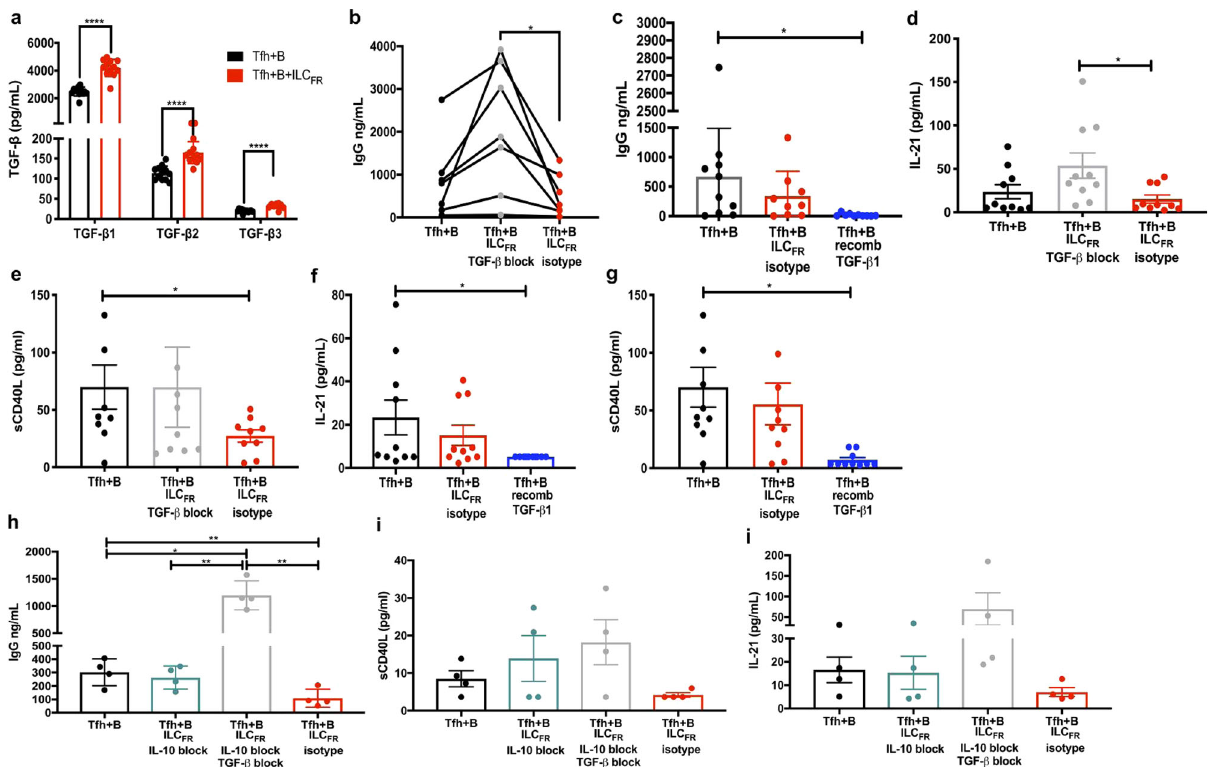
Fig. 5 ILC FR -derived TGF- β attenuates the interaction of GC-Tfh and GC-B cells and reverses with blockade. a Production of TGF- β in the supernatants of 5-day co-culture: 30,000 GC-Tfh with 30,000 autologous GC-B cells (black) plus or minus addition of 1000 ILC FR (red) plus SEB measured by Luminex ( n = 12 biologically independent tonsils per group, 3 independent experiments) (Paired, two-tailed parametric t -test; **** p < 0.0001; df = 11, β 1: 95% CI: (1352 to 2048), t = 10.76, β 2: 95% CI: (32.68 to 69.68), t = 6.09, β 3: 95% CI: (9.947 to 15.43), t = 10.18; Mean± SD). b IgG production in the supernatants of 5-day co-culture with or without blocking of TGF- β with 1ug/mL TGF- β neutralizing antibody (gray) or 1ug/mL mouse IgG isotype control (red) measured by ELISA ( n = 7 biologically independent tonsils per group, 3 independent experiments) (Ordinary one-way ANOVA with multiple comparisons; F = 8.380; * p = 0.0420; Mean ± SD). c IgG production in the supernatants of 5-day co-culture plus or minus 3000 pg/mL of recombinant human TGF- β 1 (blue) or 1ug/mL mouse IgG isotype control (red) measured by ELISA ( n = 10 tonsils per group, 4 independent experiments) (Ordinary one-way ANOVA with multiple comparisons; F = 3.658; * p = 0.0309; Mean ± SD). d Production of IL-21 and e sCD40L in supernatants of 5-day co-culture with or without ILC FR plus or minus TGF- β neutralizing antibody (gray) or isotype control (red) analyzed by 28 plex Luminex ( n = 10 biologically independent tonsils per group, 4 independent experiments) (Ordinary one-way ANOVA with multiple comparisons; IL-21: F = 3 = 4.131; * p = 0.0287; sCD40L: F = 3.446; * p = 0.0415; Mean ± SD). (Paired, two-tailed parametric t -test; df = 9, sCD40L: * p = 0.0373, 95% CI: ( − 27.98 to − 1.067), t = 2.44; IL-21: Tfh + B vs block: ** p = 0.01, 95% CI: (9.346 to 51.09), t = 3.28, block vs isotype: p = .005, 95% CI: ( − 62.17 to − 14.86), t = 3.68; Mean± SD). f Production of IL-21 and g sCD40L in supernatants of 5-day co-culture with or without ILC FR plus or minus recombinant TGF- β 1 (blue) or isotype control (red) analyzed by 28 plex Luminex. ( n = 10 tonsils per group, 4 independent experiments) (Ordinary one-way ANOVA with multiple comparisons; IL-21: F = 3.654; * p = 0.0394; sCD40L: F = 5.206; * p = 0.0127; Mean± SD). h IgG production in the supernatants of 5-day co-culture plus or minus 1000 ILC FR with or without IL-10 blocking antibody (teal), or both IL-10 and TGF- β blocking antibodies (gray), or isotype control (red) B measured by ELISA. (Ordinary one-way ANOVA with multiple comparisons; F = 43.22; Tfh + B vs. IL-10 and TGF- β block: * p = 0.0325; Tfh + B vs. isotype: ** p = 0.0197; IL-10 and TGF- β block vs. isotype: p = 0.0114; IL-10 block vs. IL-10 and TGF- β block: p = 0.0175; Mean± SD). i Production of sCD40L and i IL-21 in the supernatants of 5-day co-culture plus or minus 1000 ILC FR with or without IL-10 blocking antibody (teal), or both IL-10 and TGF- β blocking antibodies (gray), or isotype control (red) measured by ELISA. ( n = 4 biologically independent tonsils per group, 2 independent experiments).